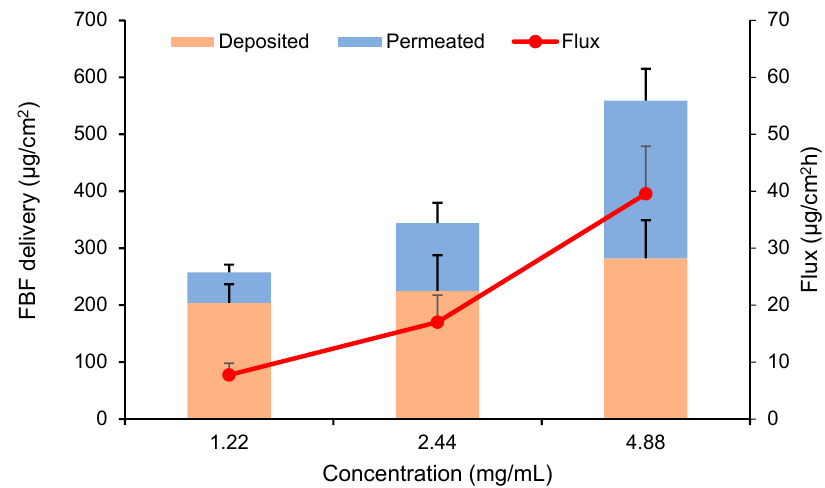
Figure 3. E ff ect of donor concentration (1.22, 2.44, and 4.88 mg / mL) on FBF delivery and the steady Figure 3. Effect of donor concentration (1.22, 2.44, and 4.88 mg/mL) on FBF delivery and the steady state flux for 8 h of transdermal iontophoresis at 0.5 mA / cm2. (Mean ± SD; n = 6). state flux for 8 h of transdermal iontophoresis at 0.5 mA/cm2. (Mean ± SD; n = 6).